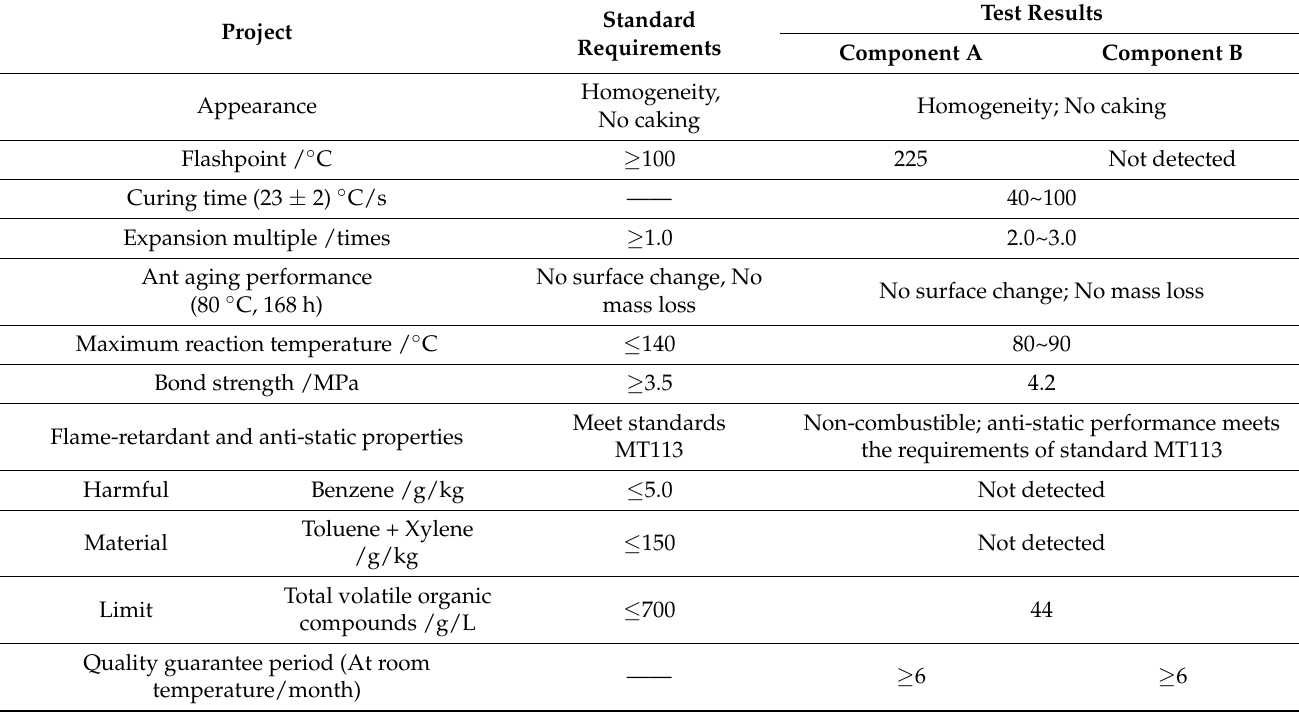
Figure 4. Laboratory test diagram. ( a ) Curing time test; ( b ) reaction temperature; ( c ) flashpoint test; ( d ) flame-retardant performance test. Table 2. Technical index of grouting material.